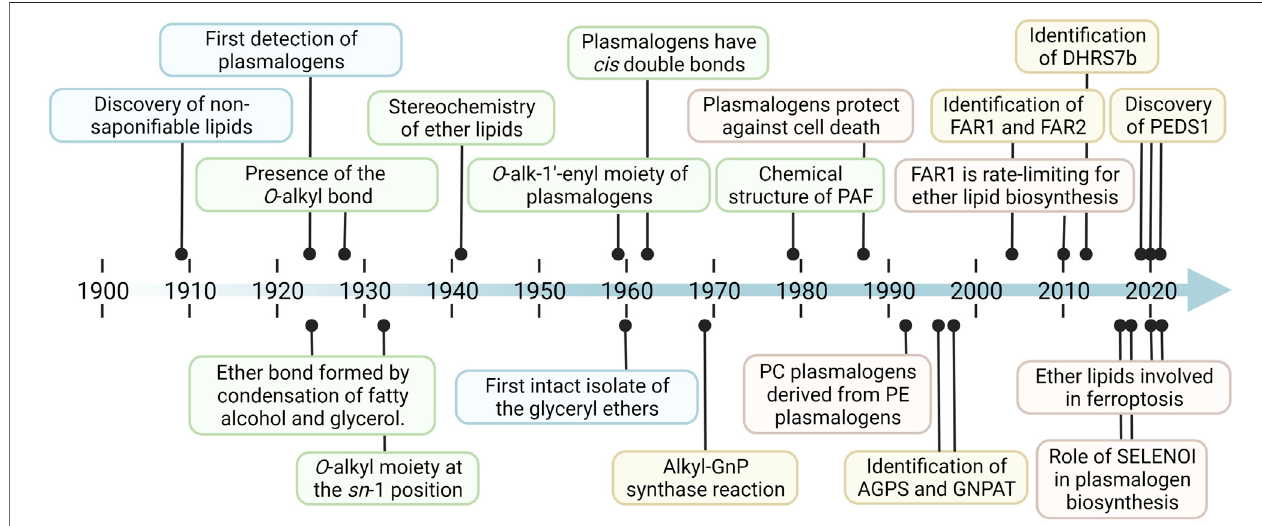
FIGURE 2 | Timeline of selected noteworthy discoveries and milestones in plasmalogen and ether lipid research. In the more than a hundred years since the fi rst evidencefortheexistenceofetherlipidswasfound,therehavebeengroundbreakingresultsonawidevarietyofconceptuallevels.Theseincludetheir1)discovery(blue), 2) structural characterization (green), 3) enzymology and metabolism (yellow), and 4) function and physiological roles (red). Corresponding references and additional pioneering fi ndings are listed in Table 1 .